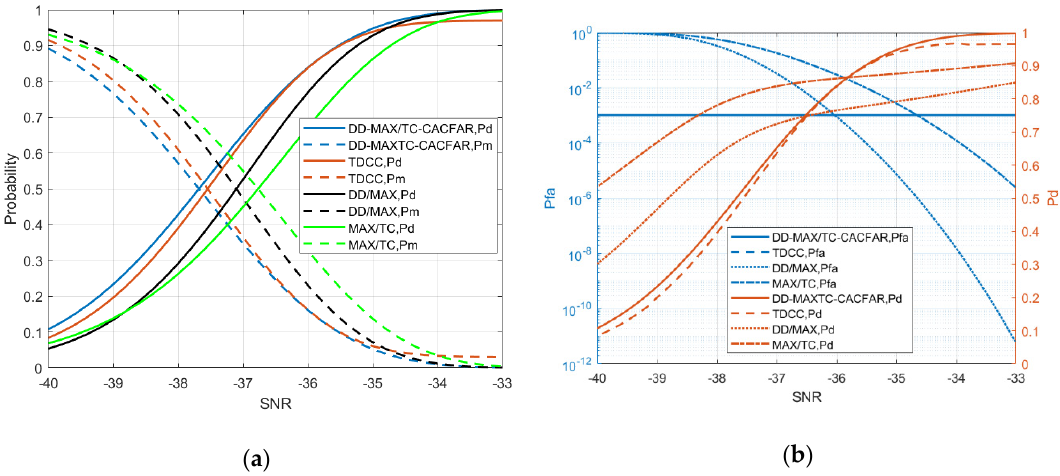
Figure 14. ( a ) P d and P m versus SNR (P fa = 0.001) (noise power remains constant); ( b ) P d and P fa Figure 14. ( a ) P (cid:2914) and P (cid:2923) versus SNR ( P (cid:2916)(cid:2911) = 0.001 ) (noise power remains constant); ( b ) P (cid:2914) and P (cid:2916)(cid:2911) versus SNR (signal power remains constant). versus SNR (signal power remains constant).